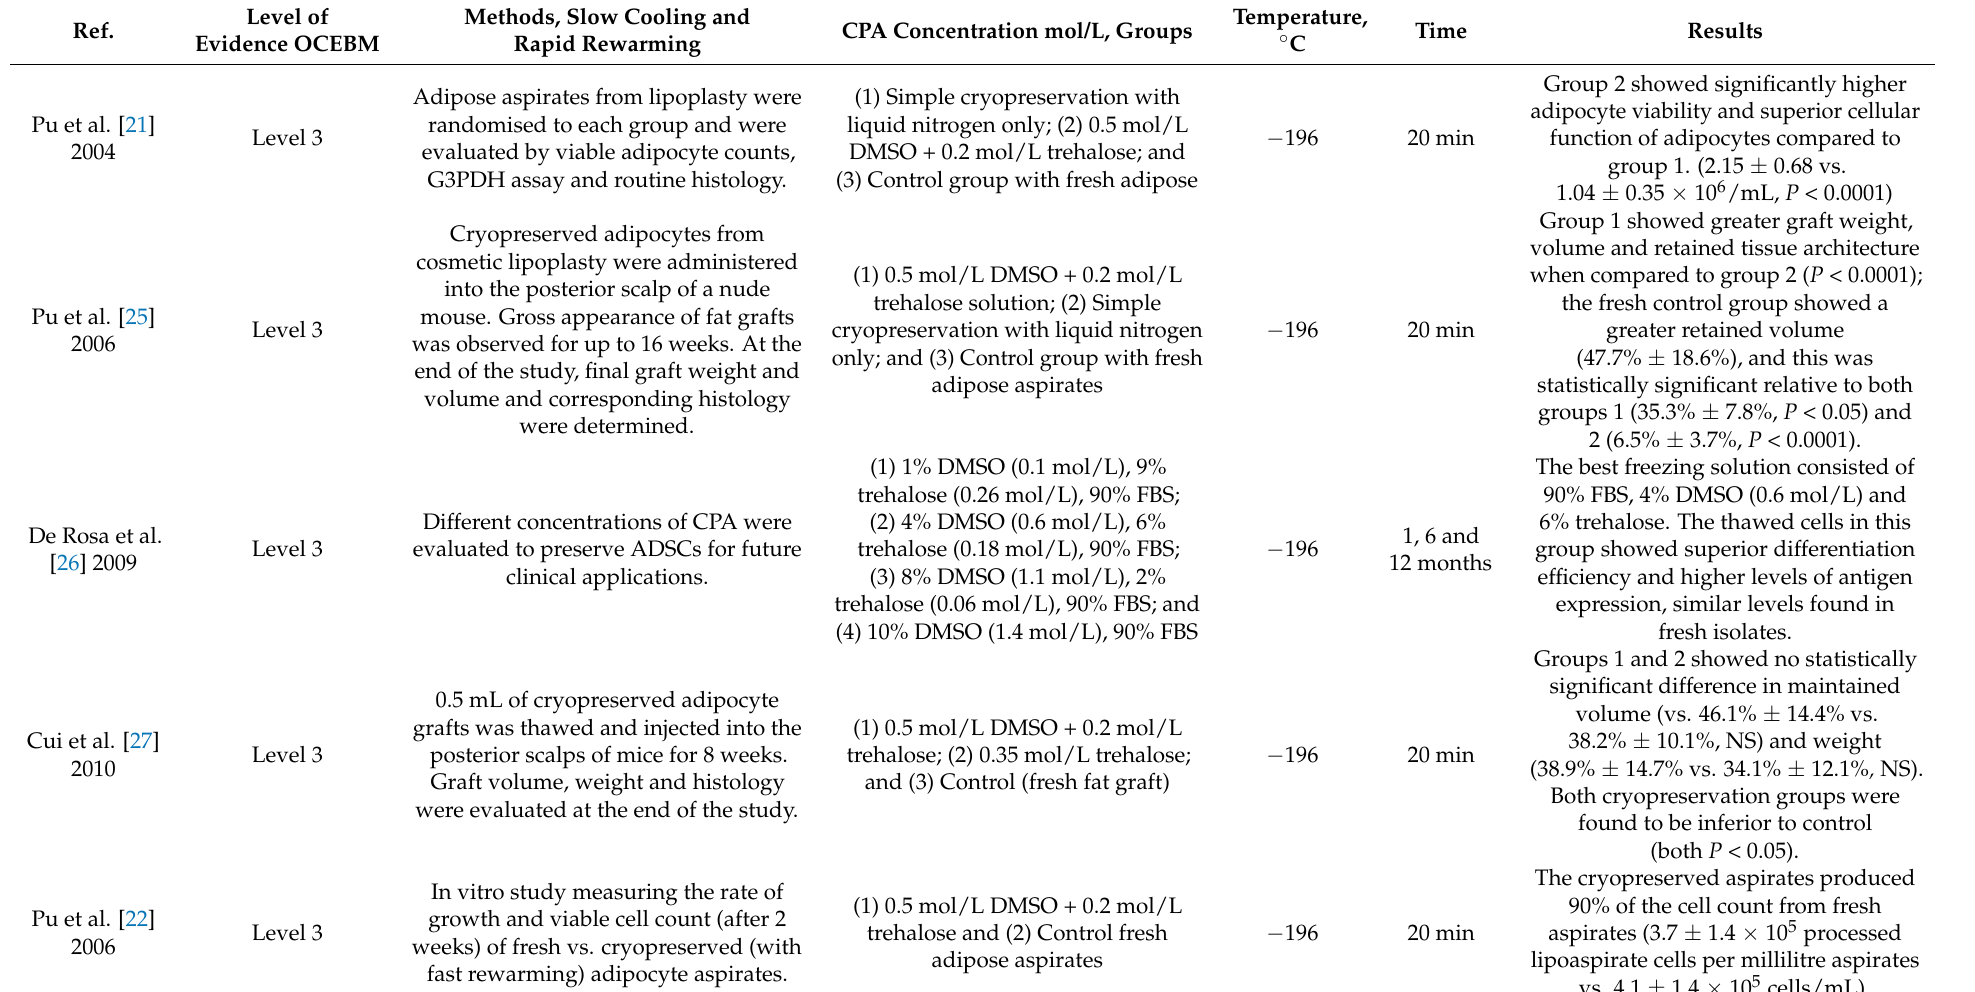
Table 1. Cryopreservation with trehalose and dimethyl sulfoxide